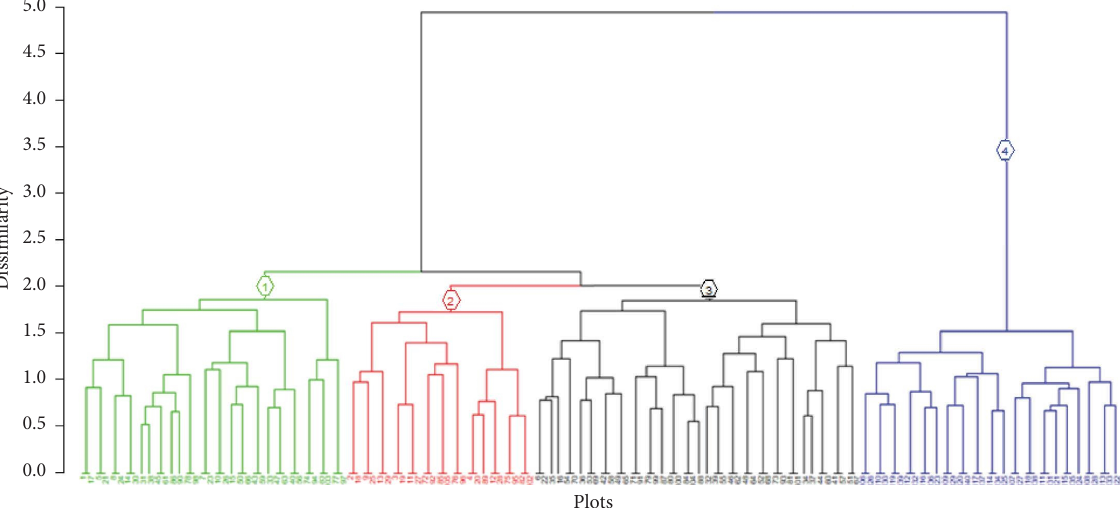
Figure 4: Dendrogram of the cluster analysis results of species abundance found in 140 of MFBR. C1:1, 17, 5, 21, 8, 24, 14, 30, 31, 38, 45,